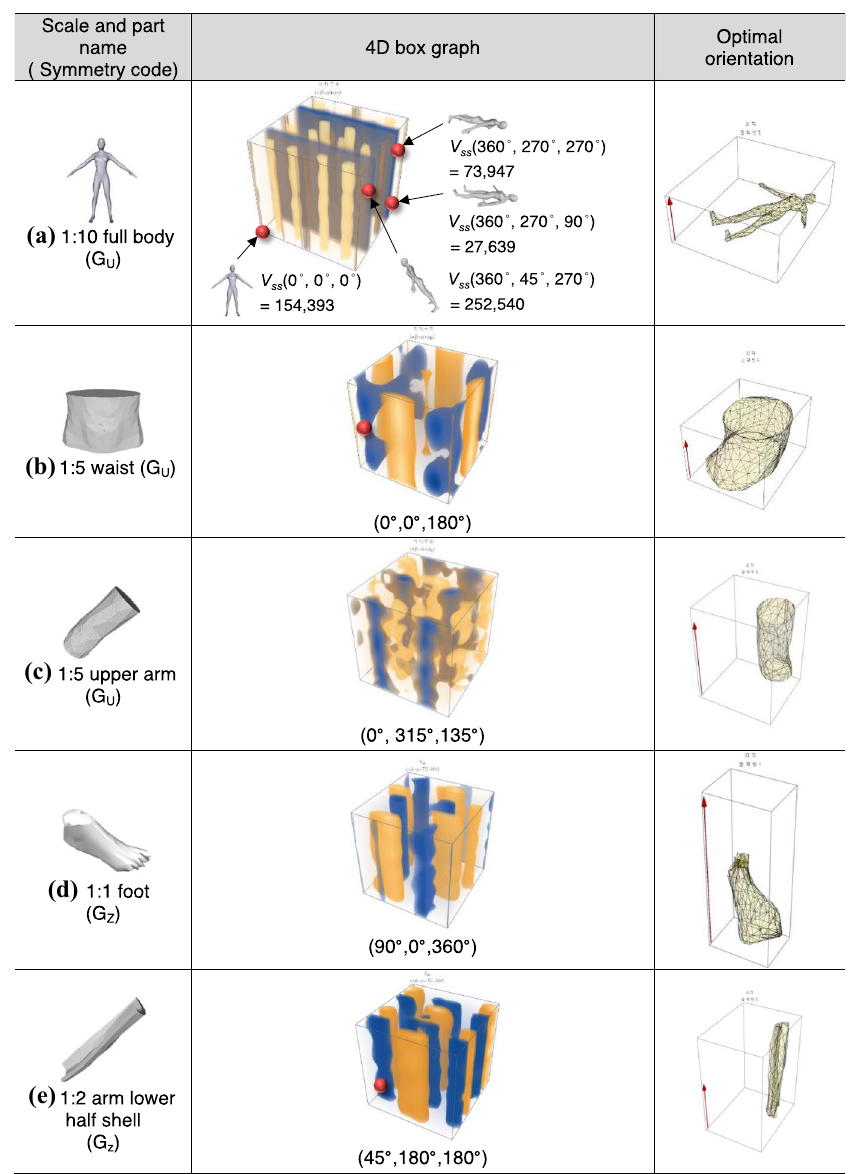
Fig. 8 4D box graph representation of body parts in a several printing scales for the “Masha” manikin data (angle interval =